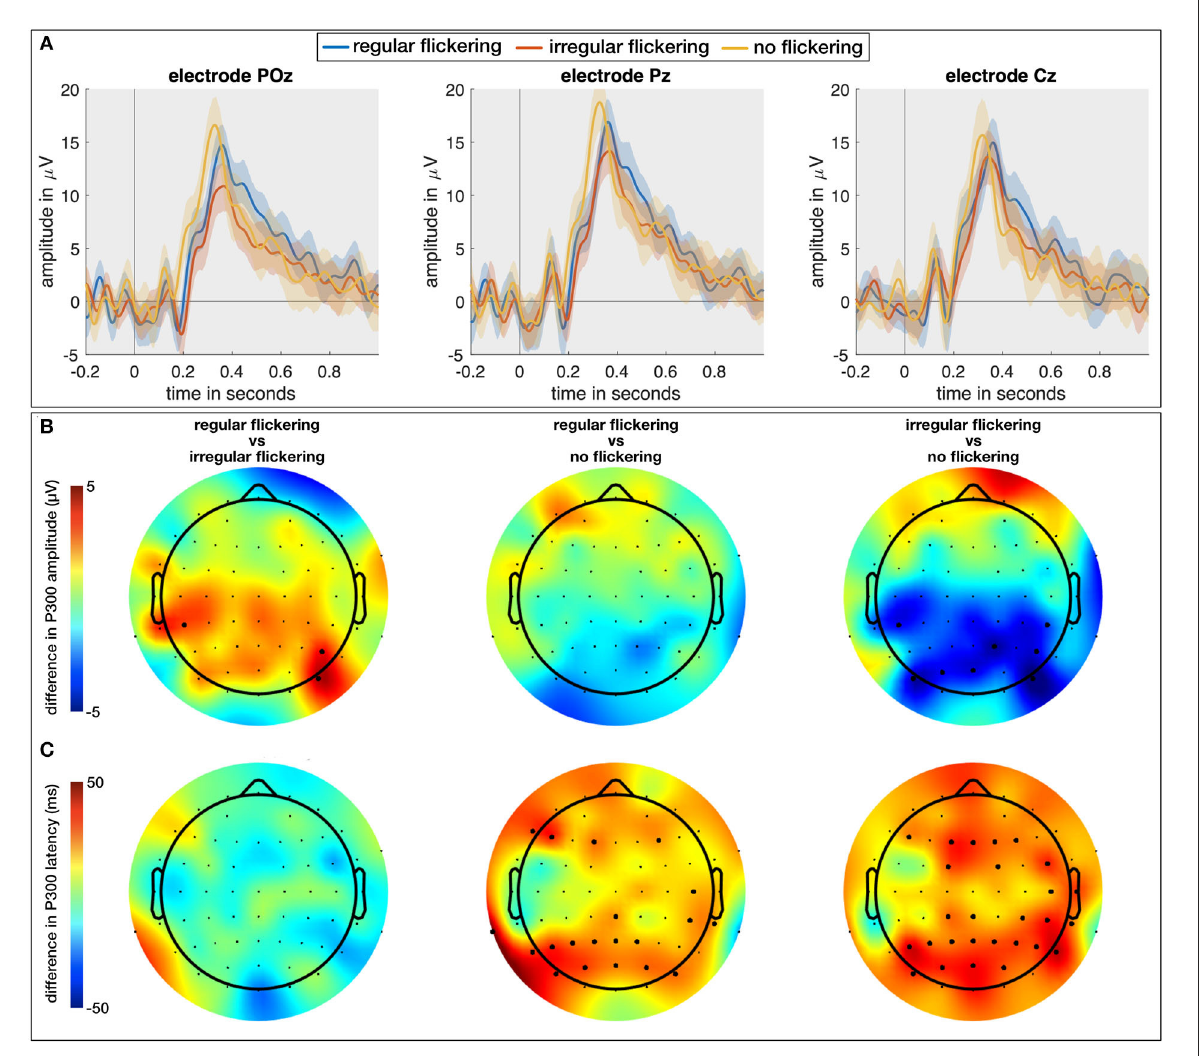
FIGURE6 (A) The temporal plots (ERPs) in response to regular-oddball, irregular-oddball, and no-flickering-oddball conditions on electrodes POz, Pz, and Cz. Shaded area indicates 95% confidence interval, full-line is the average across the subjects. (B) Difference between P300 peak amplitudes [max between 200 and 600 ms (in µ V)] between groups accounting for multiple comparisons (three groups). The largest difference was observed between irregular- and no-flicker conditions with no-flicker condition exhibiting the largest P300 amplitude on several electrodes. (C) Scalp plots for differences between P300 peak latencies across three groups accounted for multiple comparisons. The P300 response to flickering stimulus (both regular and irregular) was delayed in comparison to no-flickering stimulus. The electrodes indicating a statistically significant difference in (B,C) are presented with thick